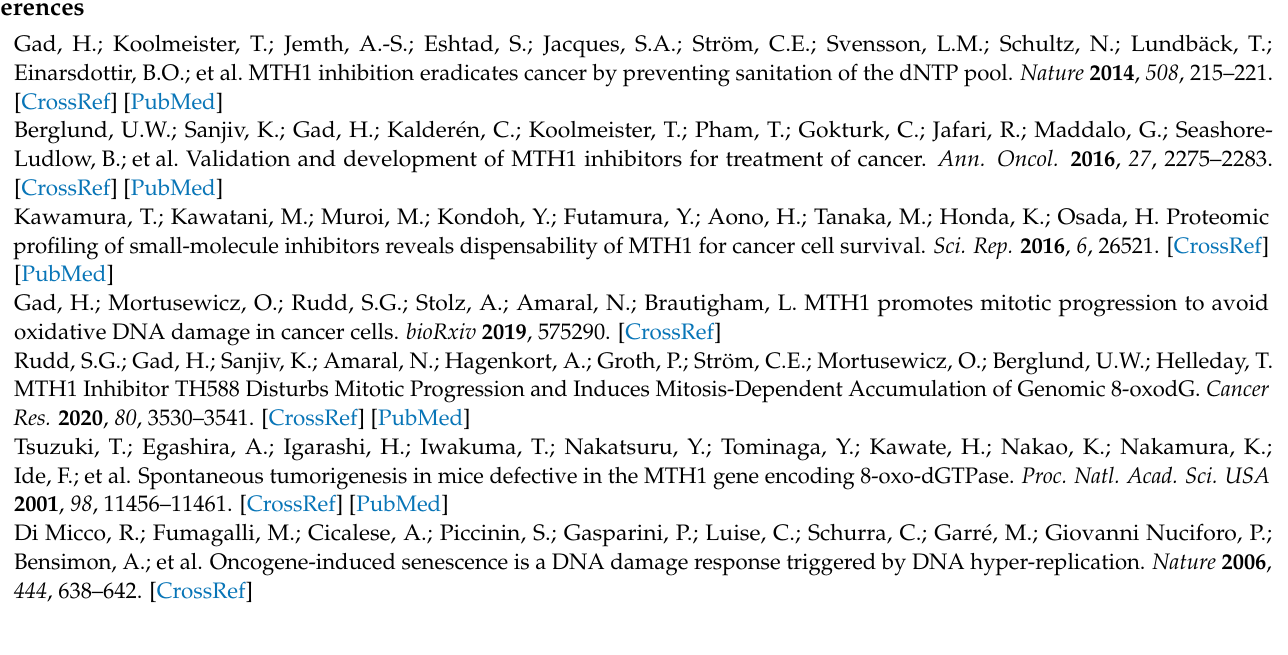
Figure S1: Proposed mechanism of TH588 and TH1579 to selectively kill cancer cells; Figure S2: Schematic illustration of cell line generation and marker levels in c-Myc HA1EB cells; Figure S3: Non-toxic MTH1 inhibitors or MTH1 silencing do not decrease c-Myc levels; Figure S4: Viability of used inhibitors in Empty-4 and c-Myc-4 HA1EB cell lines. Figure S5. Uncropped Western blots for Figure 1b. Figure S6. Uncropped Western blots for Figure S2e. Figure S7. Uncropped Western blots for Figure S3a. Figure S8. Uncropped Western blots for figure S3c. Figure S9. Representative uncropped Western blots for figure S3d–e. Figure S10. Representative uncropped Western blots forFigure 5a. Figure S11. Uncropped Western blots for Figure 5b. Figure S12. Uncropped Western blots for Figure